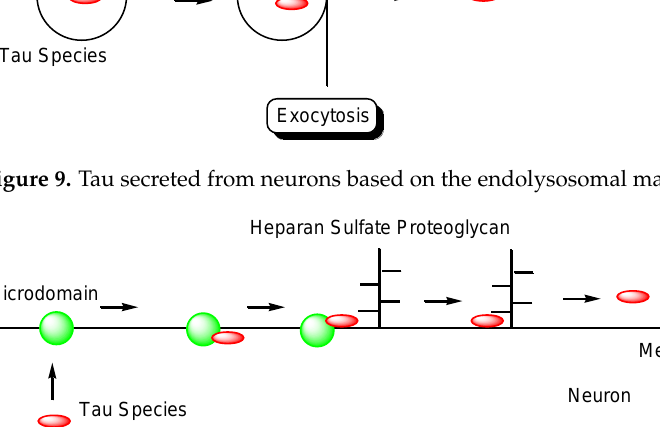
Figure 10. Tau secreted from neurons through an unconventional non-vesicular mechanism.